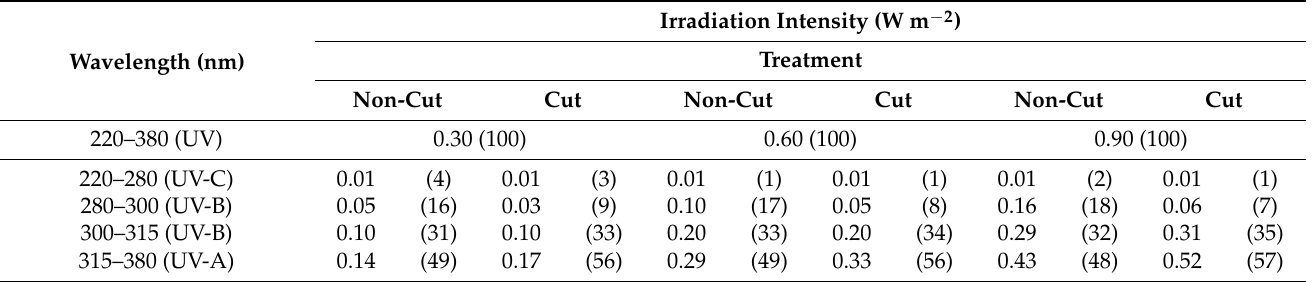
Table 2. Spectral characteristics of UV irradiation conditions for each